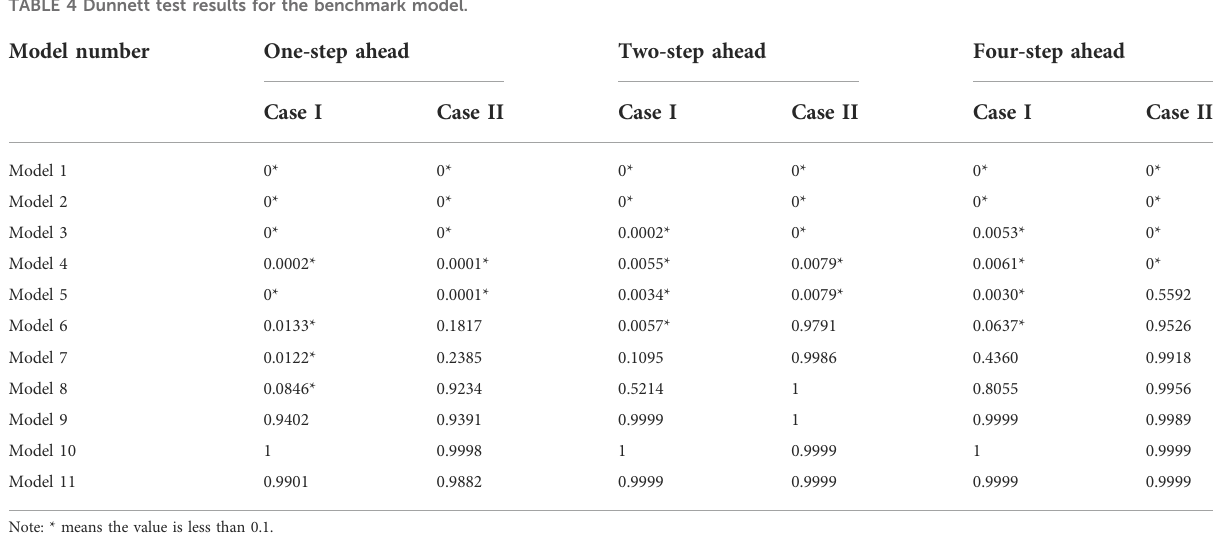
TABLE 4 Dunnett test results for the benchmark model.